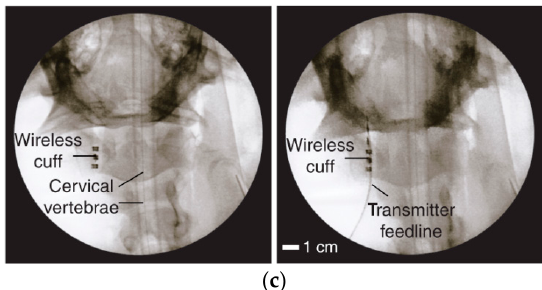
Figure 33. Wireless peripheral nerve neuromodulation system [160]. ( a ) Conformal wireless powering